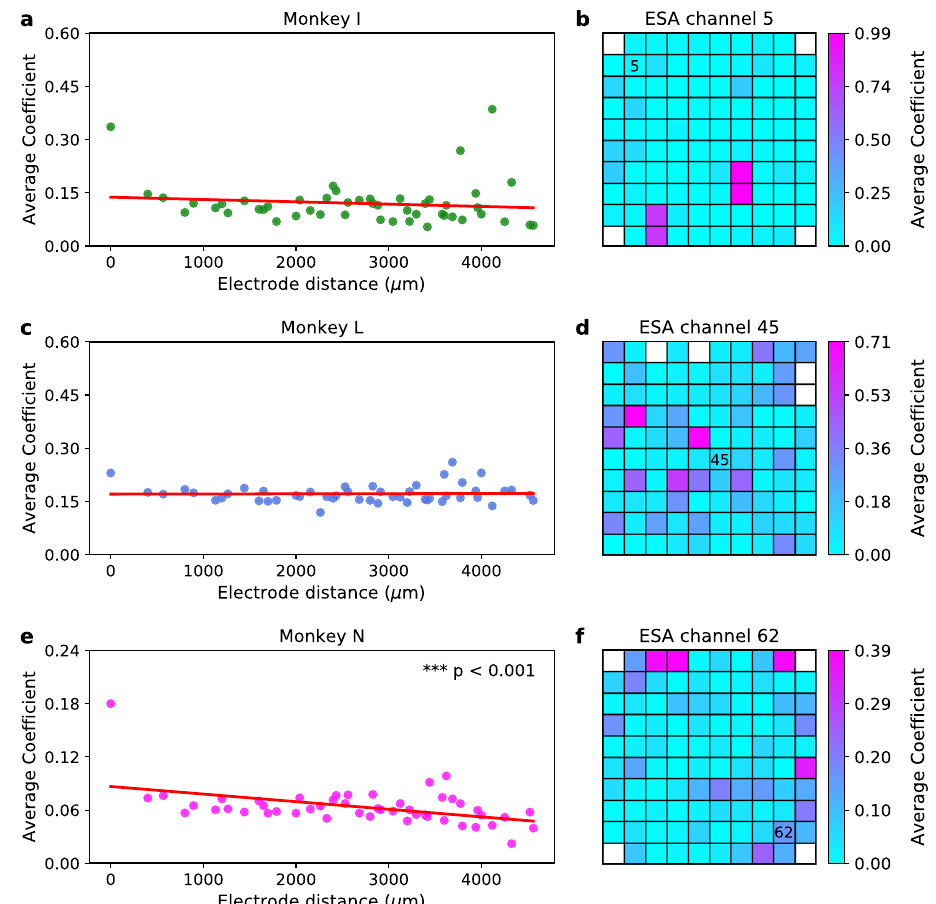
Figure 6. LFP channel importance score (quantified in terms of average coefficient) for ESA inference across subjects. ( a , c , e ) Scatter plot of LFP importance score over inter-electrode distance (μm) from monkey I, L, and N, respectively. Red solid lines represent linear regression lines used to test whether or not there is a significant linear trend between inter-electrode distance and LFP channel importance score. Asterisks indicate that there is a significant linear trend (two-tailed one-sample t test; *** p < 0.001 ). ( b , d , f ) Examples of heatmap of LFP channel importance score for ESA inference from monkey I (channel 5), monkey L (channel 45), and monkey N (channel 62), respectively. The importance score is mapped onto a 10 × 10 grid spatially corresponding to Utah electrode array configuration. Black numbers inside the grids denote the ESA channel being inferred. White boxes on the grid represent unused (unconnected) electrodes. The larger the average coefficient, the more important is the channel for the